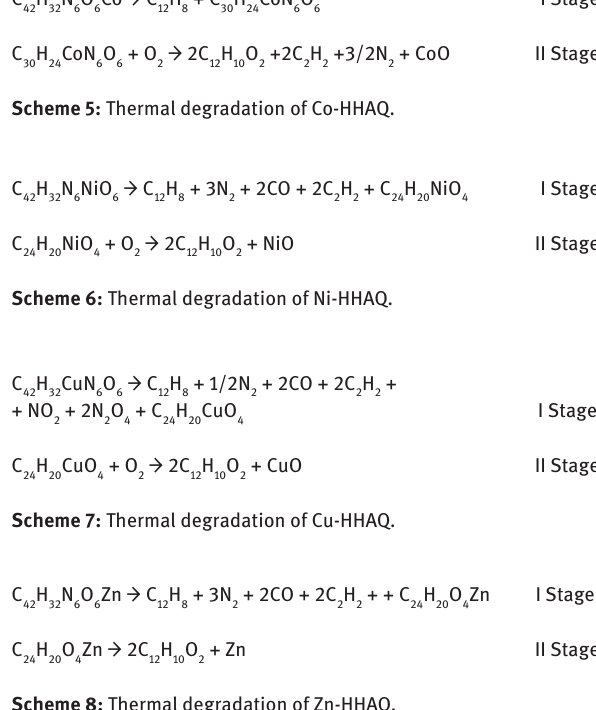
Scheme 8: Thermal degradation of